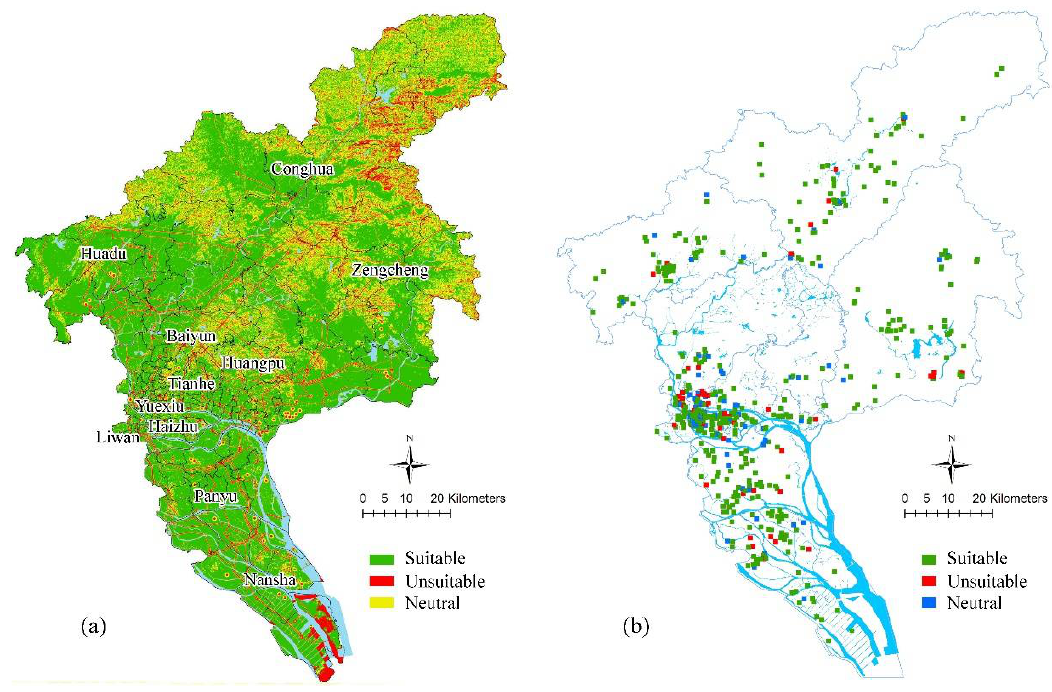
Figure 3. Assessment of ( a ) overall urban resource and ( b ) facilities considered as candidate shelters in a multi-hazard environment.